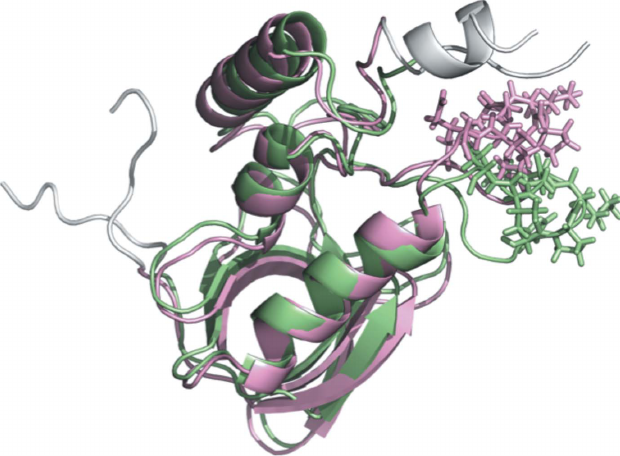
Figure 9 Snapshots of protein 31 at 110 ns (green) and 1001 ns (pink). The seven residues at the N-terminus (left) and C-terminus (upper right), ignored in the rotational fit, are colored white. The SD of the Euler angle of the rotational fit decreases by 0.7 (cid:3) when the tip of the flexible loop (residues 46–52, indicated using sticks) is removed. The image was rendered using PyMOL (https://pymol.org/).